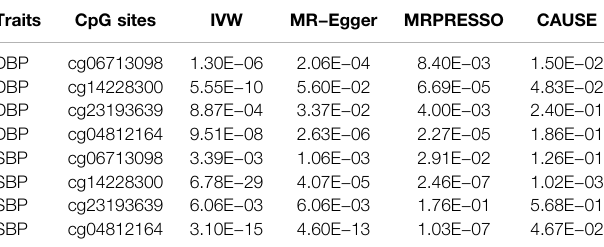
TABLE 5| p values of associations between the four CpG sites in IGFBP3 and BP in different Mendelian randomization analysis. Traits CpG